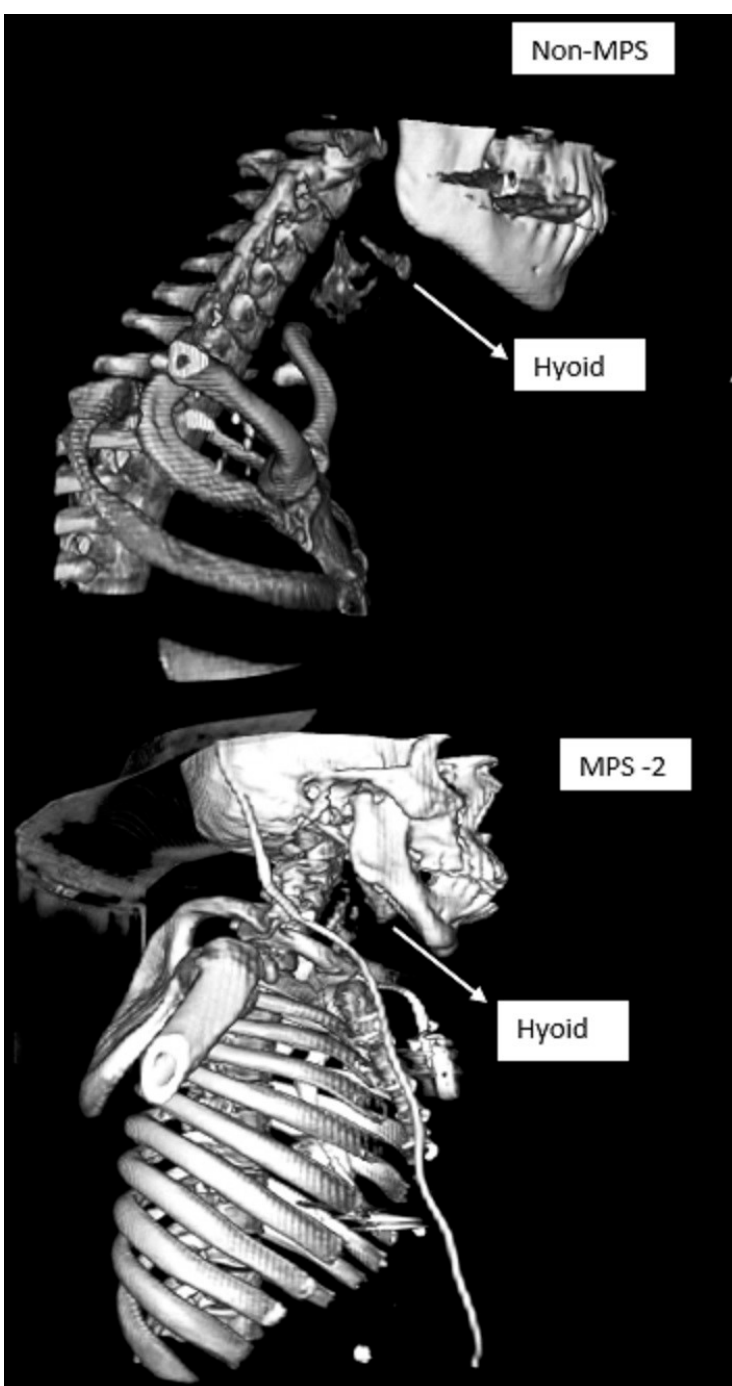
Figure 6. Three-dimensional reconstruction of the upper body skeleton, showing the level of hyoid bone in a non-MPS (top panel) and MPS-2 patient (lower panel) in relation to the mandible. A ven- triculoperitoneal shunt and pacemaker are seen in the MPS patient. MPS- Mucopolysaccharidosis.